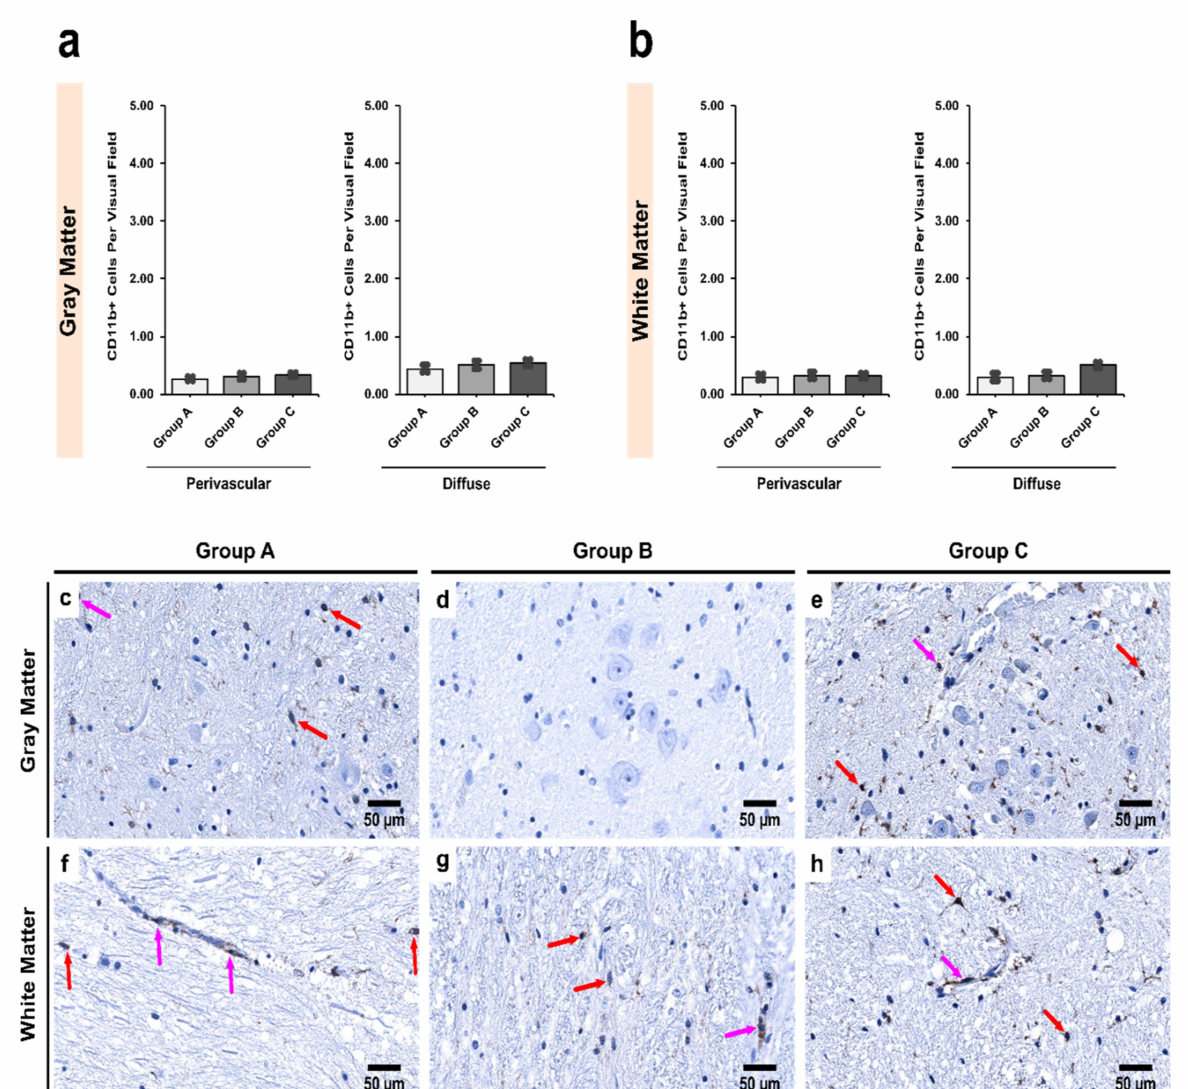
Figure 6. Intergroup analysis of CD11b+ cells per visual field in Pars Reticulata (SNpr) for the three studied groups in both ( a ) gray and ( b ) white matter. The analysis was done for both perivascular and diffuse locations. The bar plots indicate the average number of CD11b+ cells ± S.E. (Standard Error) seen per visual field. Distribution of CD11b+ cells per visual field in ( c , f ) Group A (controls); ( d , g ) Group B (age-matched alcoholics) and ( e , h ) Group C (non-age-matched alcoholics). Pink arrows indicate perivascular CD11b+ cells while red arrows indicate diffuse CD11b+ cells. Original magnification, 400 × . Scale bars, 50 µ